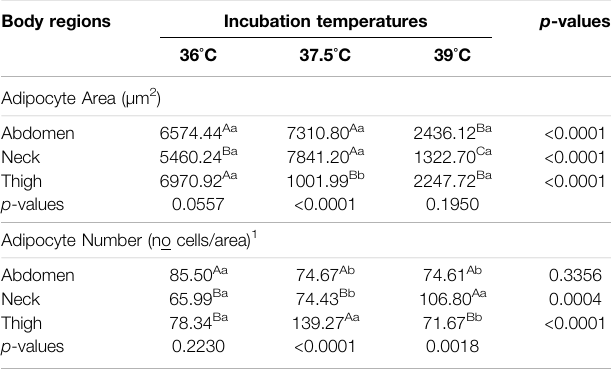
TABLE4| Unfoldingoftheinteractionbetweenincubationtemperaturesandbody regions on the adipocyte area and number of 42 d. old male broilers. Body regions